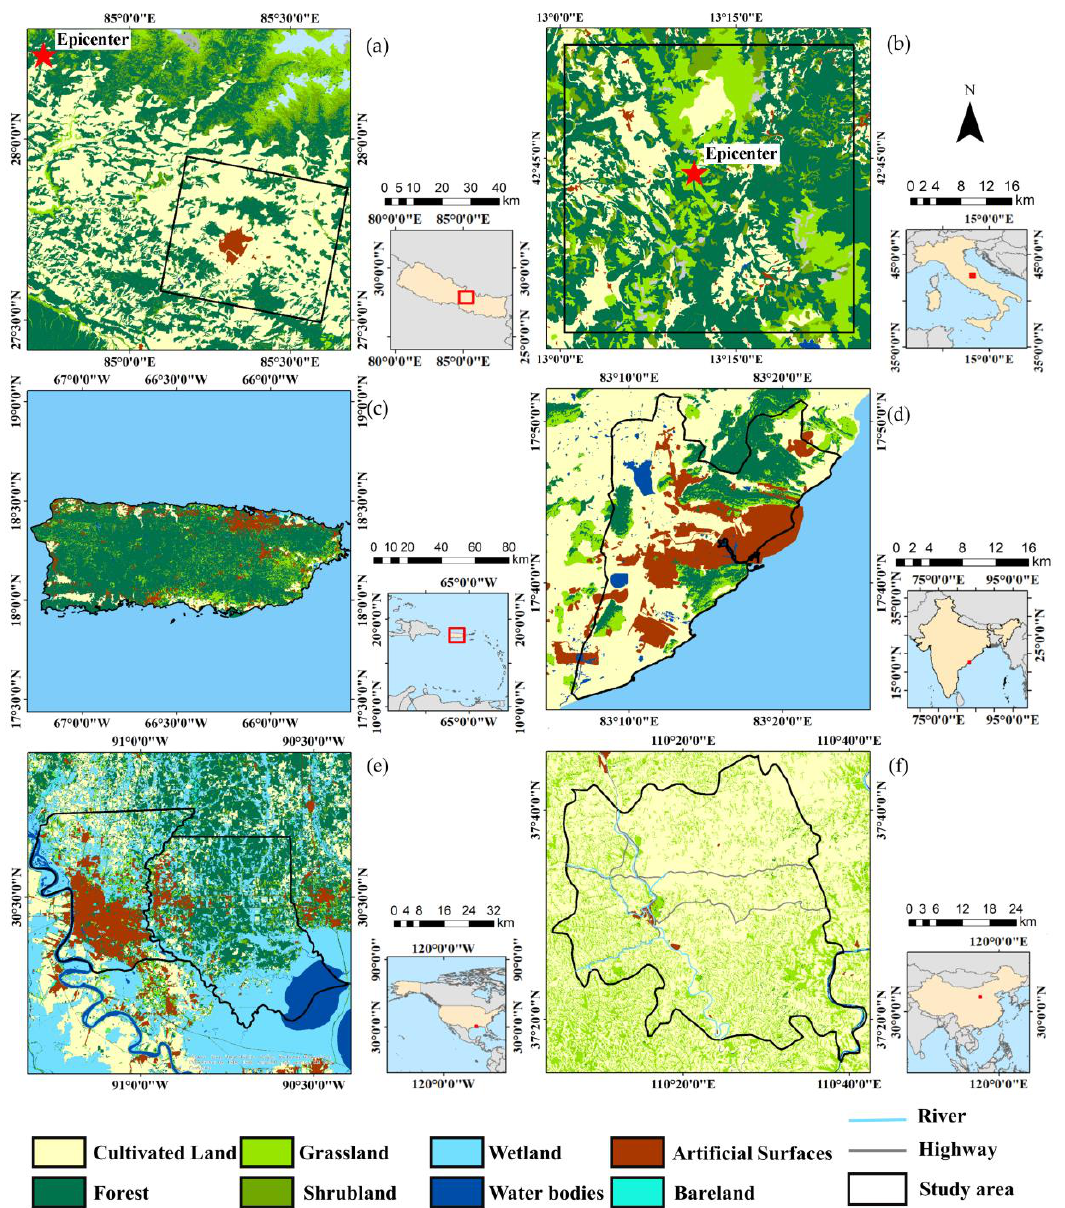
Figure 1. The location and land cover categories from the National Geomatics Center of China of each study site of the six disaster events: ( a ) Gorkha Nepal Earthquake, ( b ) Central Italy Earthquake, ( c ) Hurricane Maria, ( d ) Tropical Cyclone Hudhud, ( e ) Louisiana Flood, and ( f ) Yulin Flood.